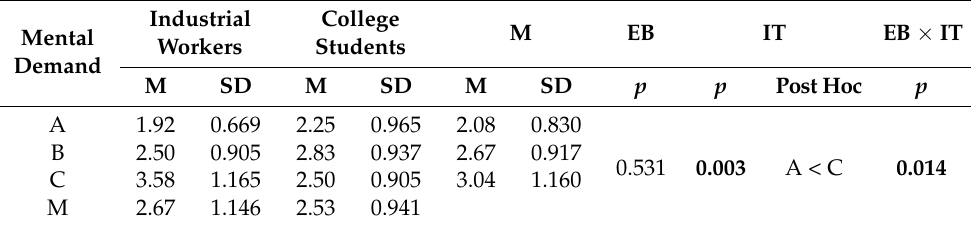
Table 5. Descriptive statistics and two-way ANOVA on mental demand by NASA-Task Load Index